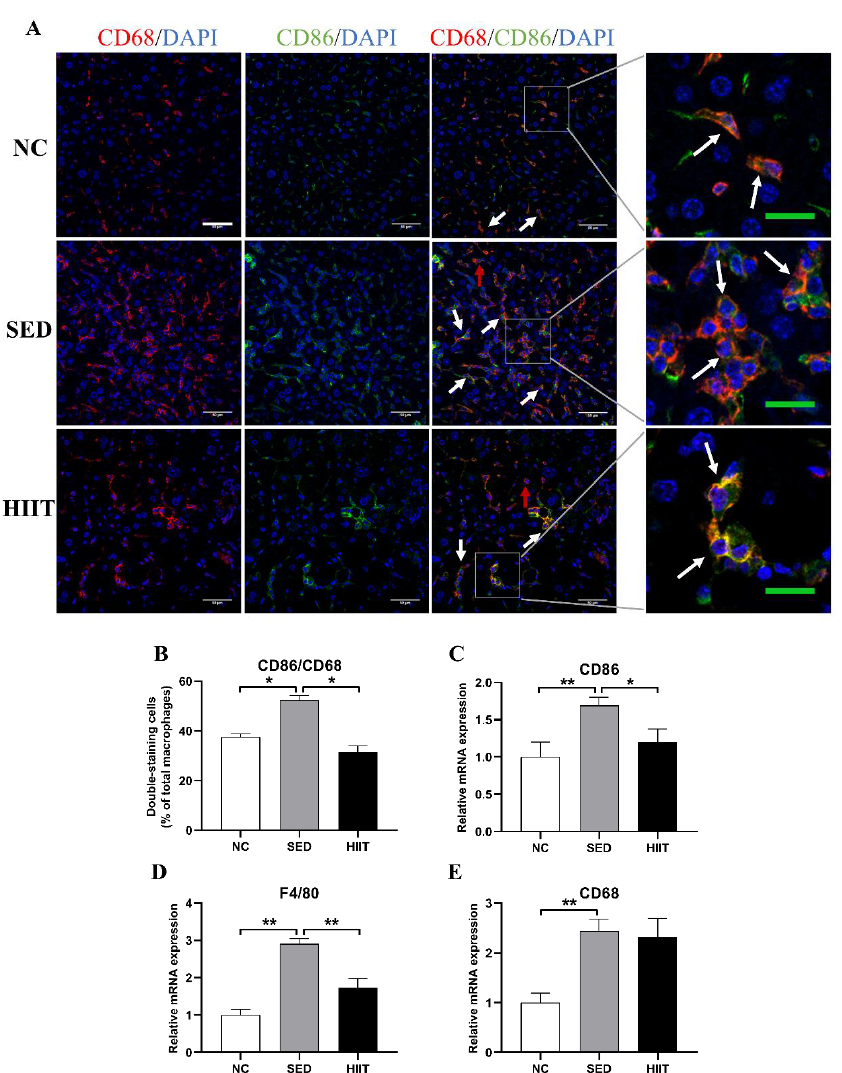
Figure 5. HIIT decreases the pro-inflammatory polarization of liver macrophages in T2DM mice. ( A ) CD86/CD68 (M1) immunofluorescence double labeling results. ( B ) Percentage of CD86/CD68-positive cells (n = 3 per group). ( C – E ) The mRNA expression of CD86, F4/80 and CD68 (n = 8 per group). The white scale is 50 μm. The green scale is 20 μm. The red arrow indicates CD68 single-positive cells. The white arrow indicates CD86 and CD68 double-positive cells. Values are mean ± SEM. * p < 0.05, ** p < 0.01. 3.6. HIIT Increases the Anti-Inflammatory Polarization of Liver Macrophages in T2DM Mice The immunofluorescence results of this study showed that (Figure 6A,B), compared with the NC group, the number of anti-inflammatory macrophages (M2) in the SED group decreased significantly, while HIIT significantly increased the number of M2 macro- phages. From the results of Western blot and qPCR, the expression of Arg1 protein (Figure